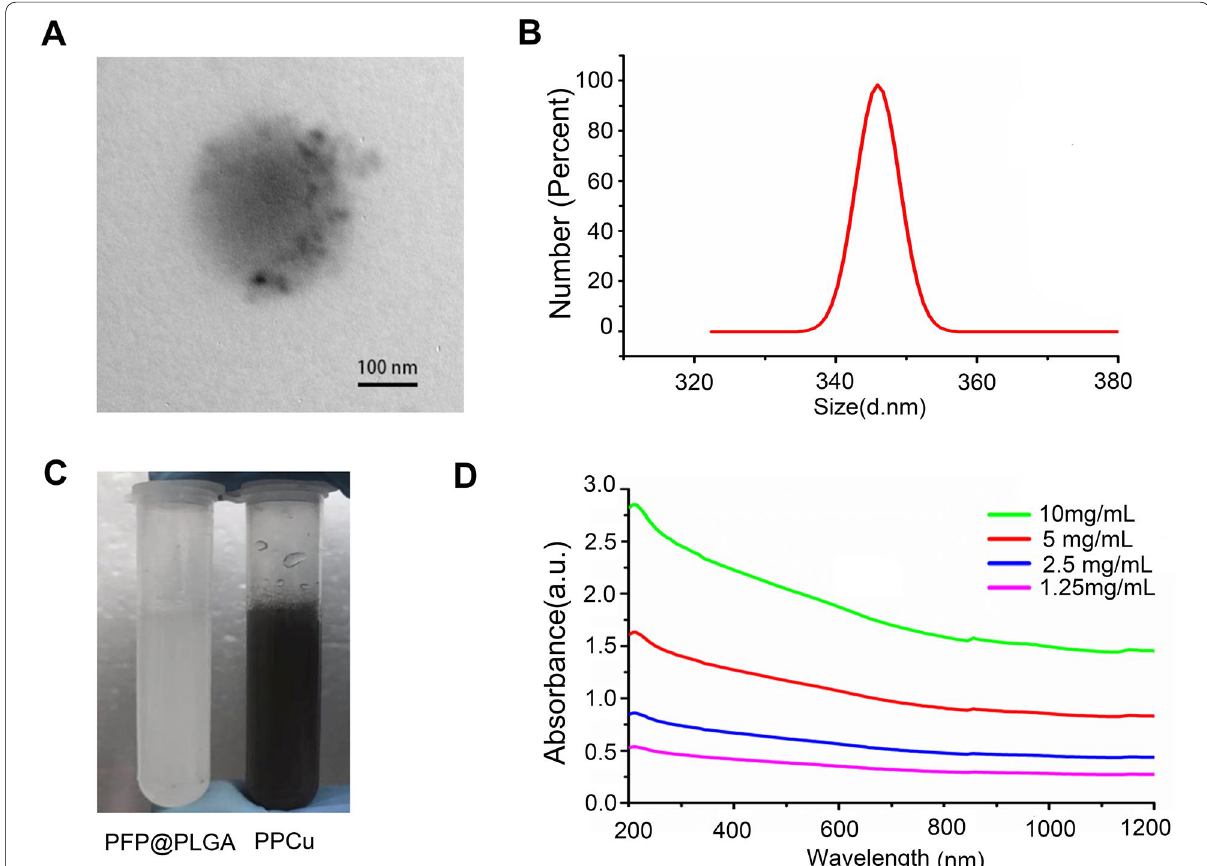
Fig. 1 Preparation and characterization of the new PTT agent. A TEM of PPCu. B Size distribution of PPCu. C Photographs of PFP@PLGA and PPCu dispersed in deionized water. D UV to NIR absorbance of PPCu in different